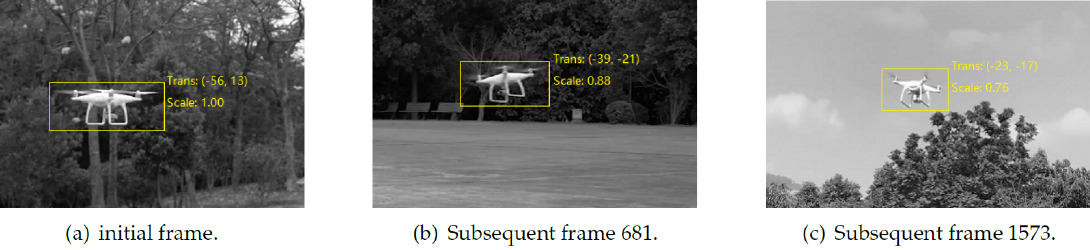
Figure 1. A visual tracking application for the flight of an unmanned aerial